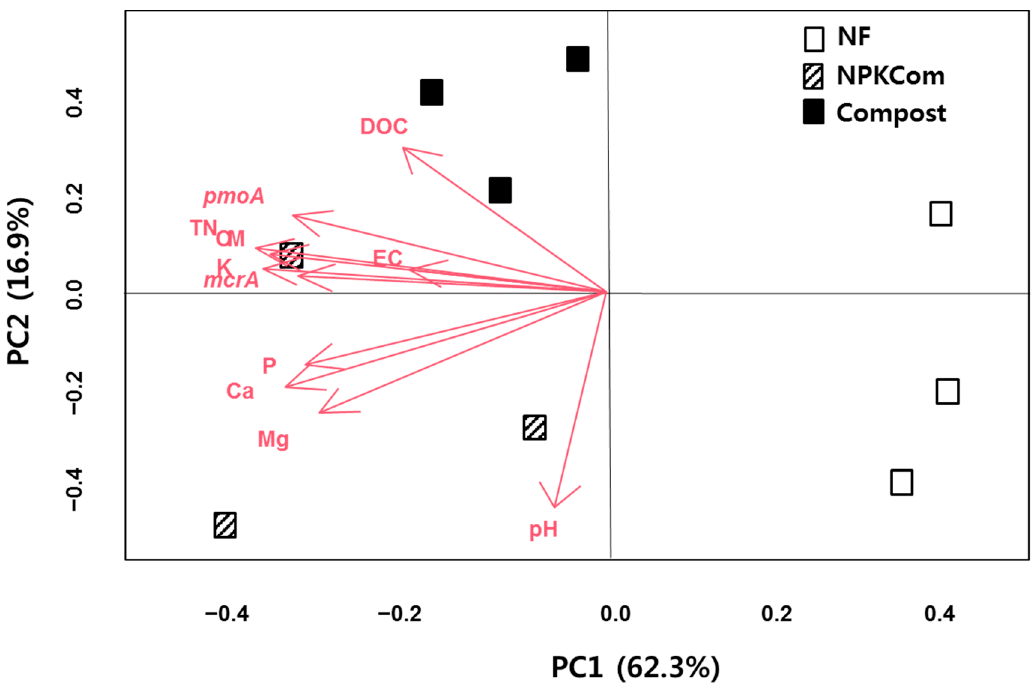
Figure 1. Principal component analysis (PCA) score plot of paddy fields under long-term compost fertilization based on the soil chemical properties and the abundance of methanogenesis and methane oxidation functional genes. NF—unfertilized control; NPKCom—chemical fertilizer (NPK)+compost; Com—compost.